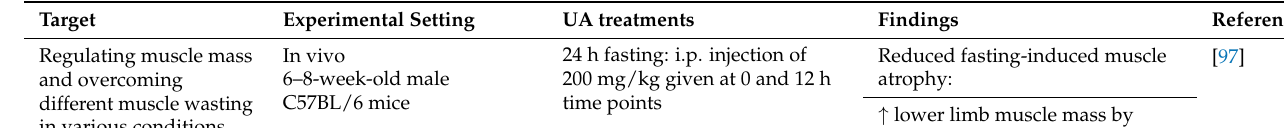
Table 2. Effects of Ursolic acid on skeletal muscle in vivo and in